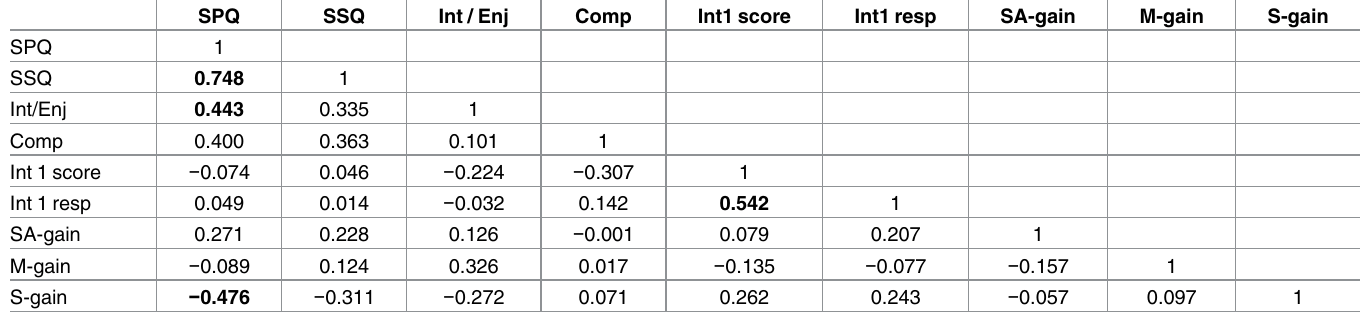
Table 5. NP-condition correlations. Pearson product-moment correlationcoefficients for the NP conditionbetweenthe post-experiment questionnaires, first interaction score and response, and the overalllearninggain. Cells in bold denotecorrelationssignificantat least at the .05